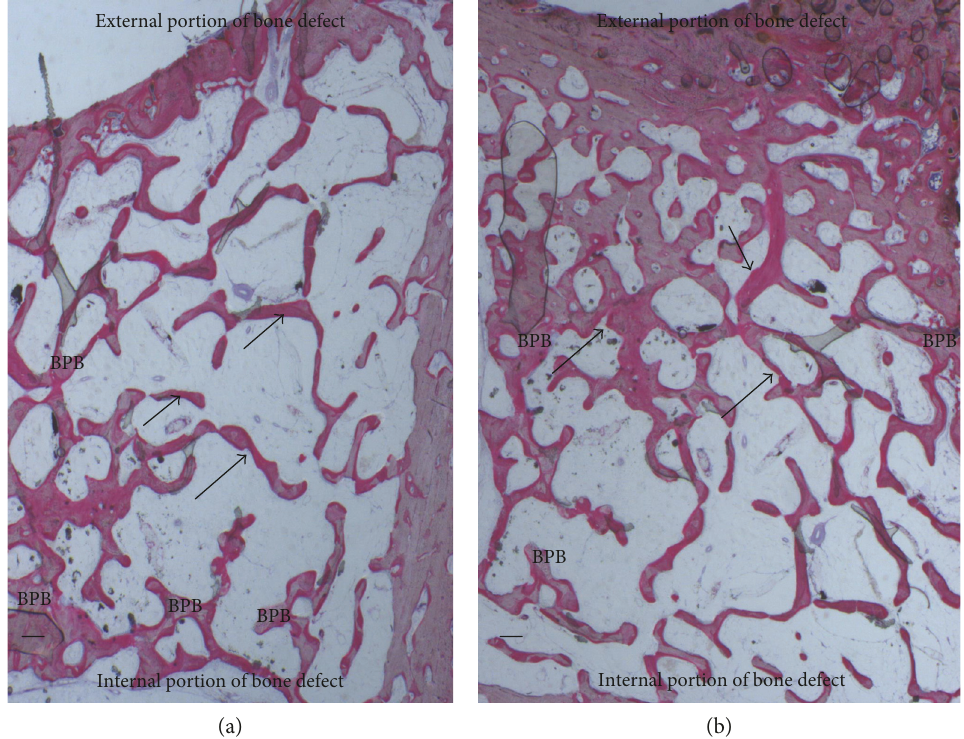
Figure 5: (a) BPB group. New bone surrounded the block material (BPB). New bone (arrows) extended also in the central part of the bone defects. Acid fuchsin and toluidine. Bar=200 μ . (b) BPB/BMSSCs group. New bone (arrows) was deposited in the block material (BPB). No fi brous tissue was observed in the defect area. Acid fuchsin and toluidine. Bar=200 μ